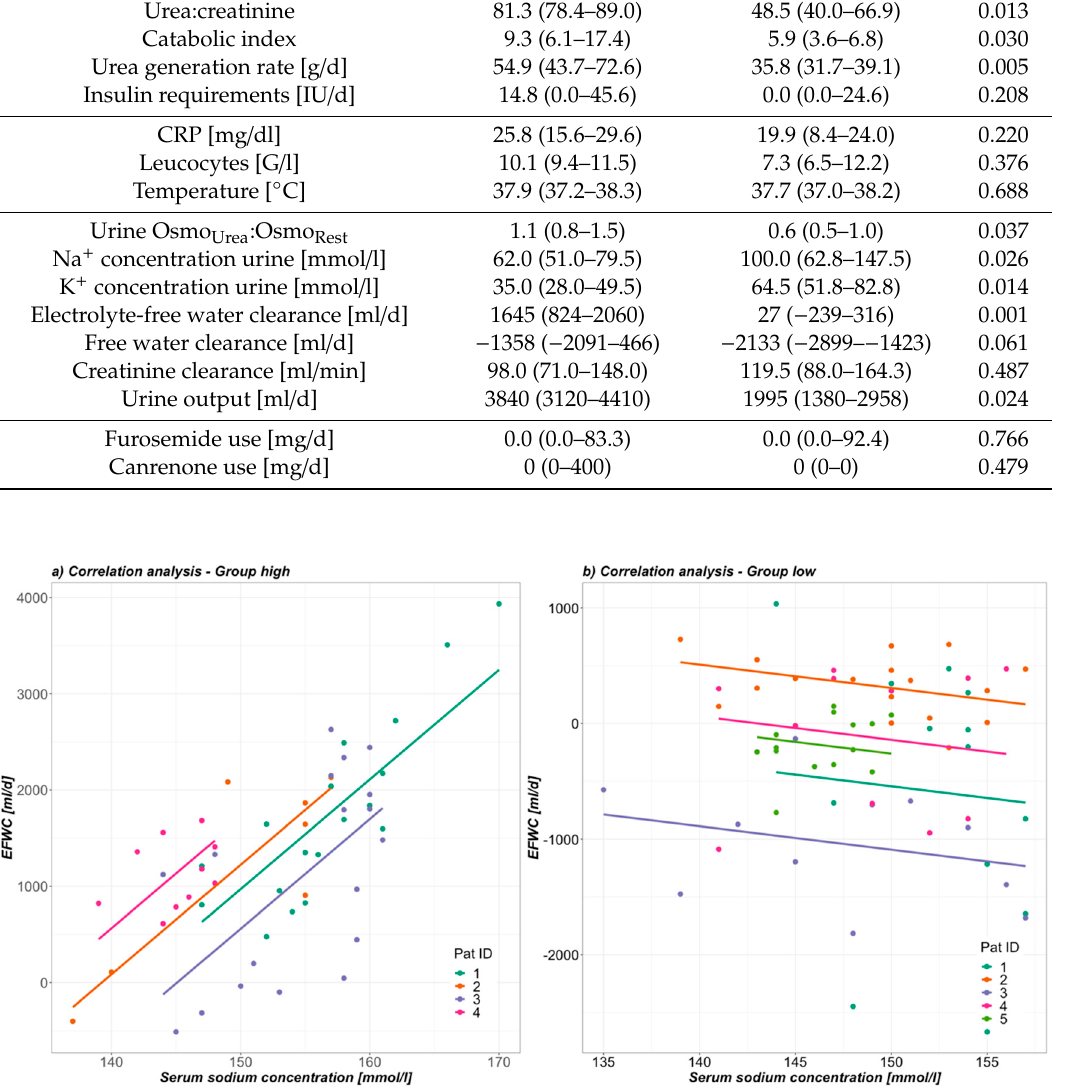
Figure 3. Correlation between EFWC and NaS during hypernatremic phase in ( a ) group high and ( b ) group low .